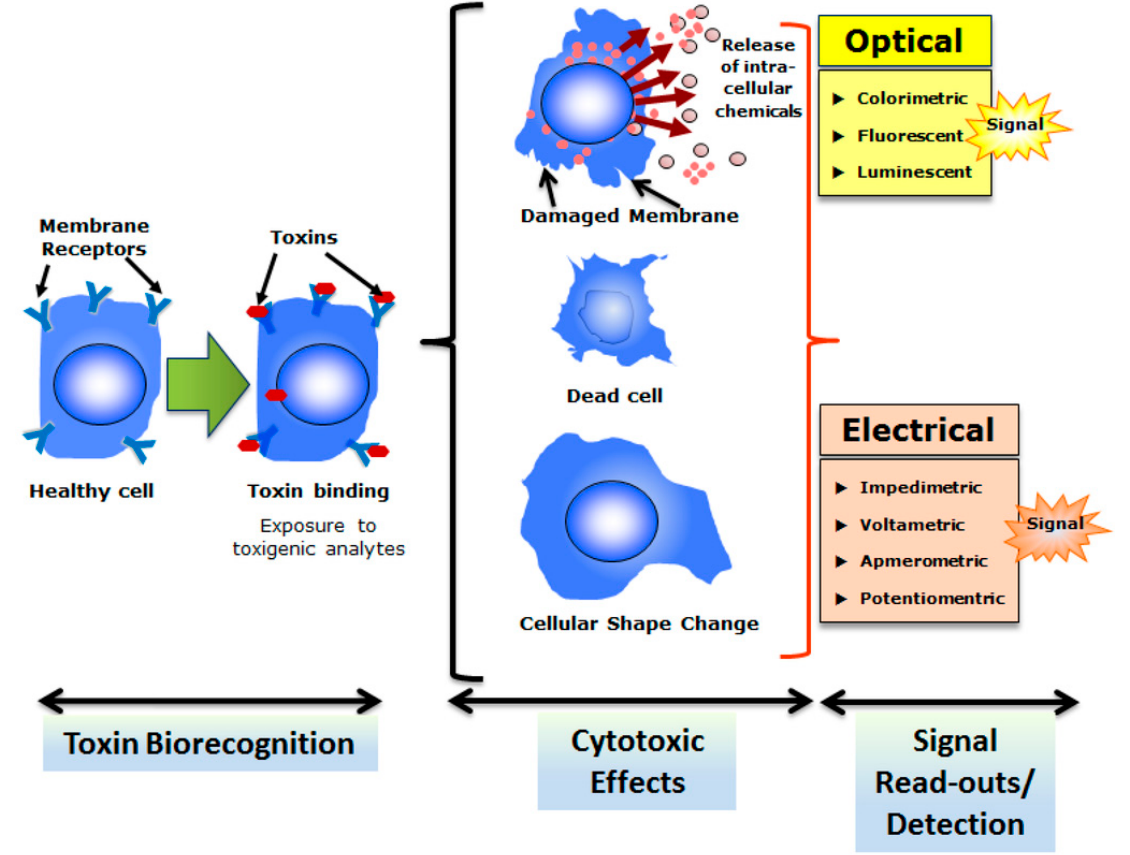
Figure 3. The overall strategy of cell-based biosensing exploiting cytotoxicity of select toxins. Cells with appropriate recognition elements (often membrane receptors) respond to respective toxins which result in cytotoxicity. Reproduced from Banerjee et al. [28], an open-access article distributed under the terms and conditions of the Creative Commons Attribution license (http://creativecommons.org/licenses/by/3.0/).